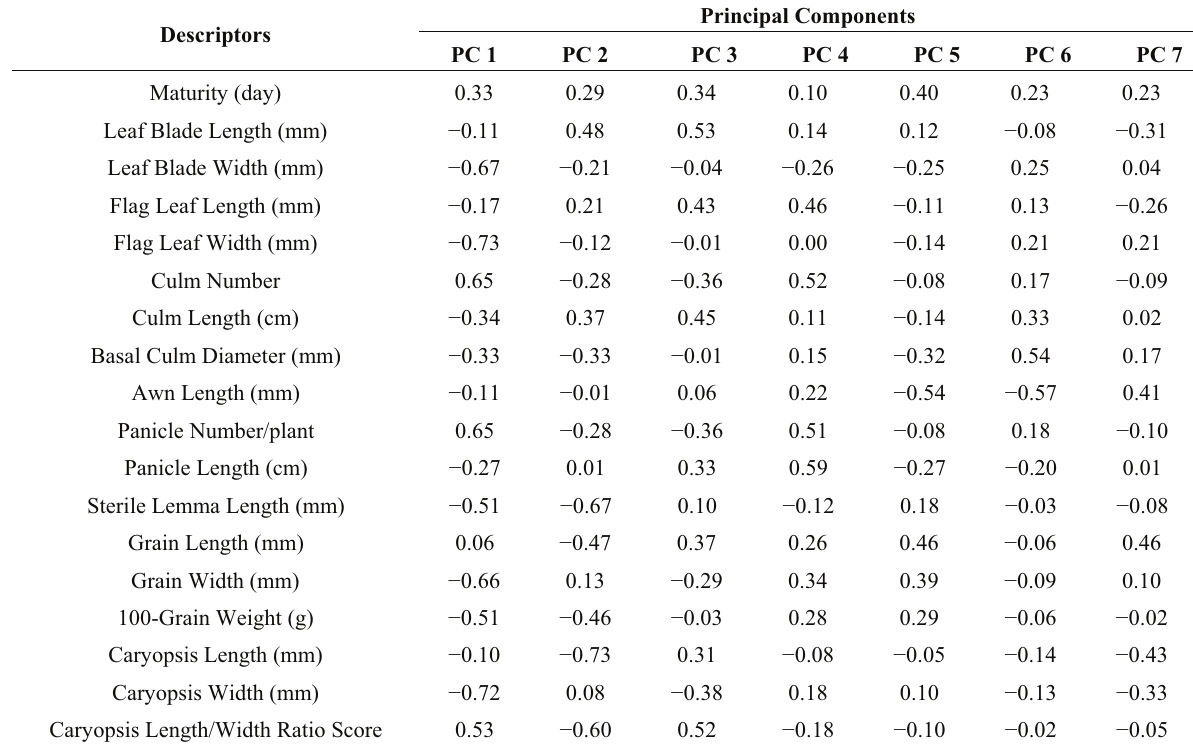
Table 4. Factor loadings (eigenvectors) for the different morphological characters for the principal components